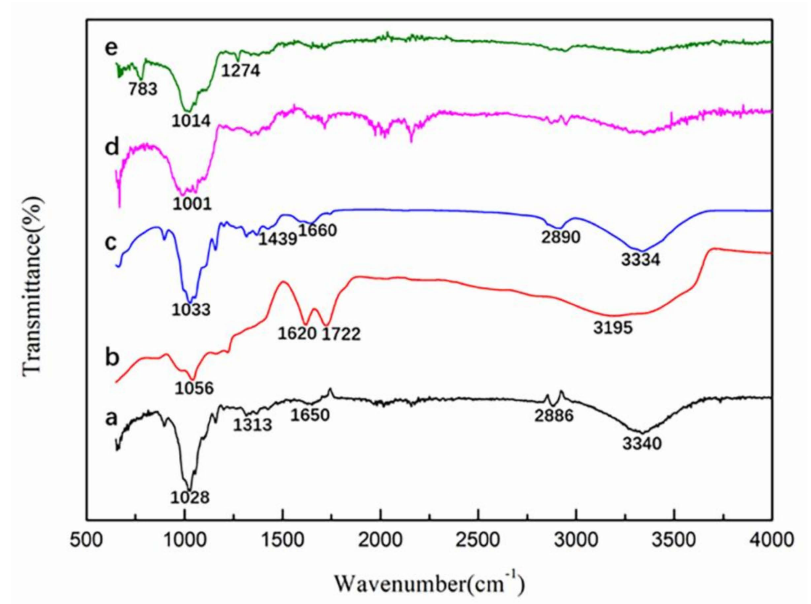
Figure 4. FTIRspectraof( a )CNFs, ( b )GO,( c )PVA,( d )CNF / PVA / GOand( e )TMCS / CNF / PVA /